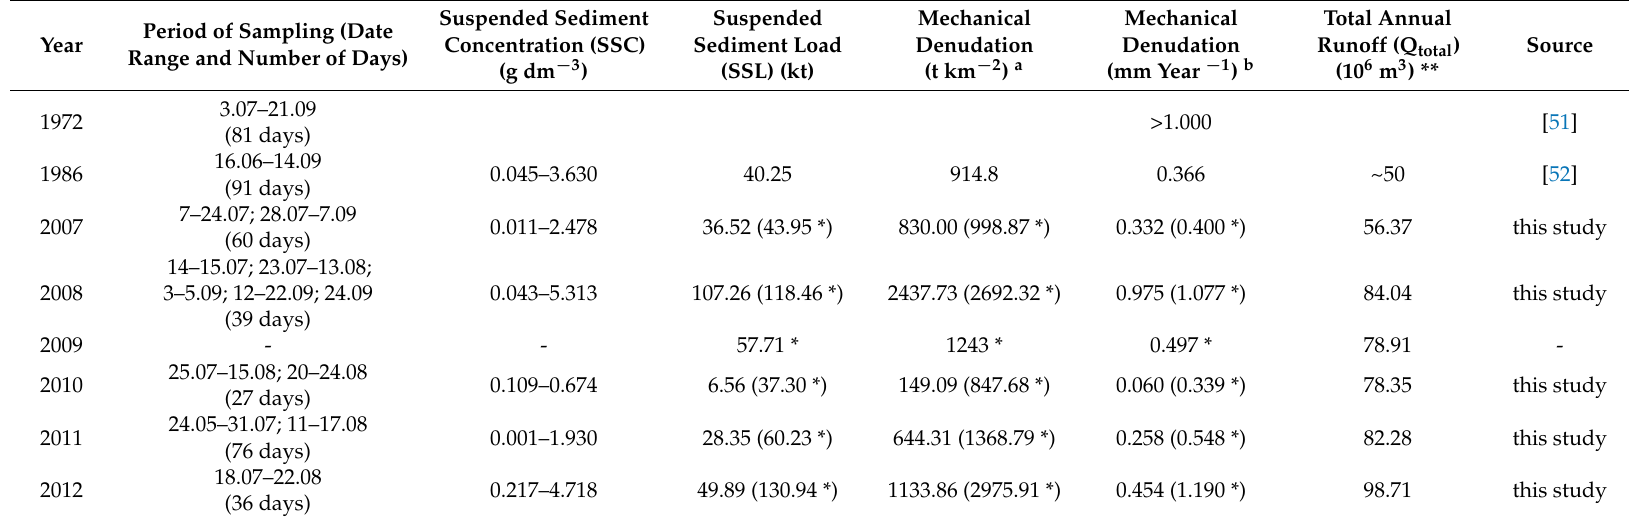
Table 1. The suspended sediment concentration (SSC), suspended sediment load (SSL), and the rate of mechanical denudation and total annual runoff (Q total ) from Werenskioldbreen catchment in the studied seasons (1972, 1986 and